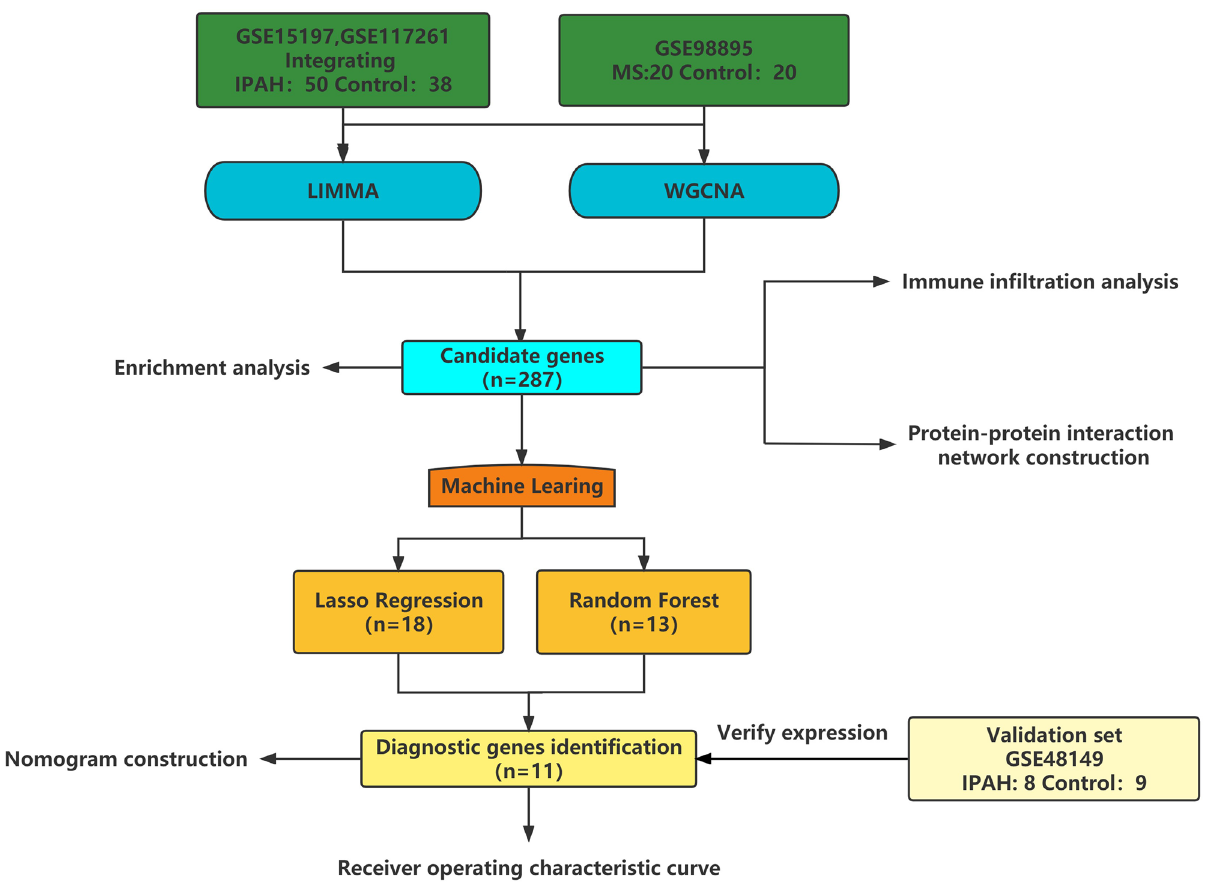
Figure 1. Flow chart of this study. Dawn by WPS office